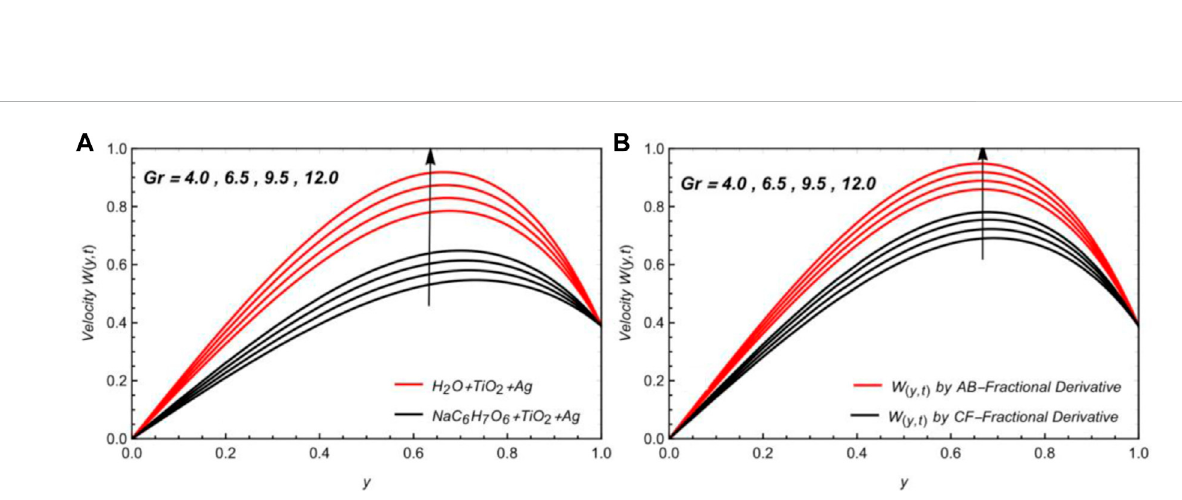
FIGURE 7 W ( y , t ) due to variation in Gr with α , β (cid:2) 0 . 5 , φ (cid:2) 0 . 02 , M (cid:2) 1 . 65 , Ra (cid:2) 1 . 2 , K eff (cid:2) 0 . 7 , Gm (cid:2) 6 . 3 , β 1 (cid:2) 1 . 5 , θ (cid:2) π /4 , and t (cid:2) 0 .